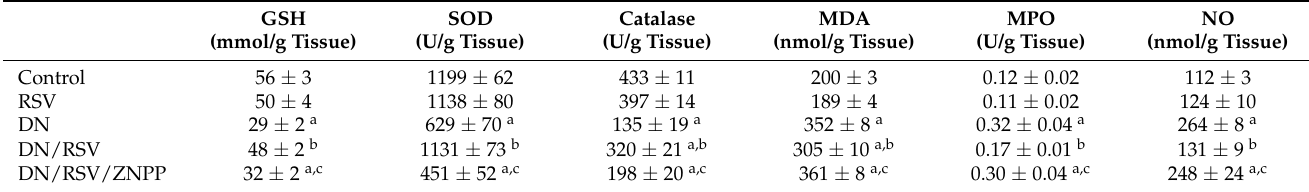
Table 5. Effect of rosuvastatin (RSV) on renal tissue oxidative stress markers in diabetic nephropathy (DN) in